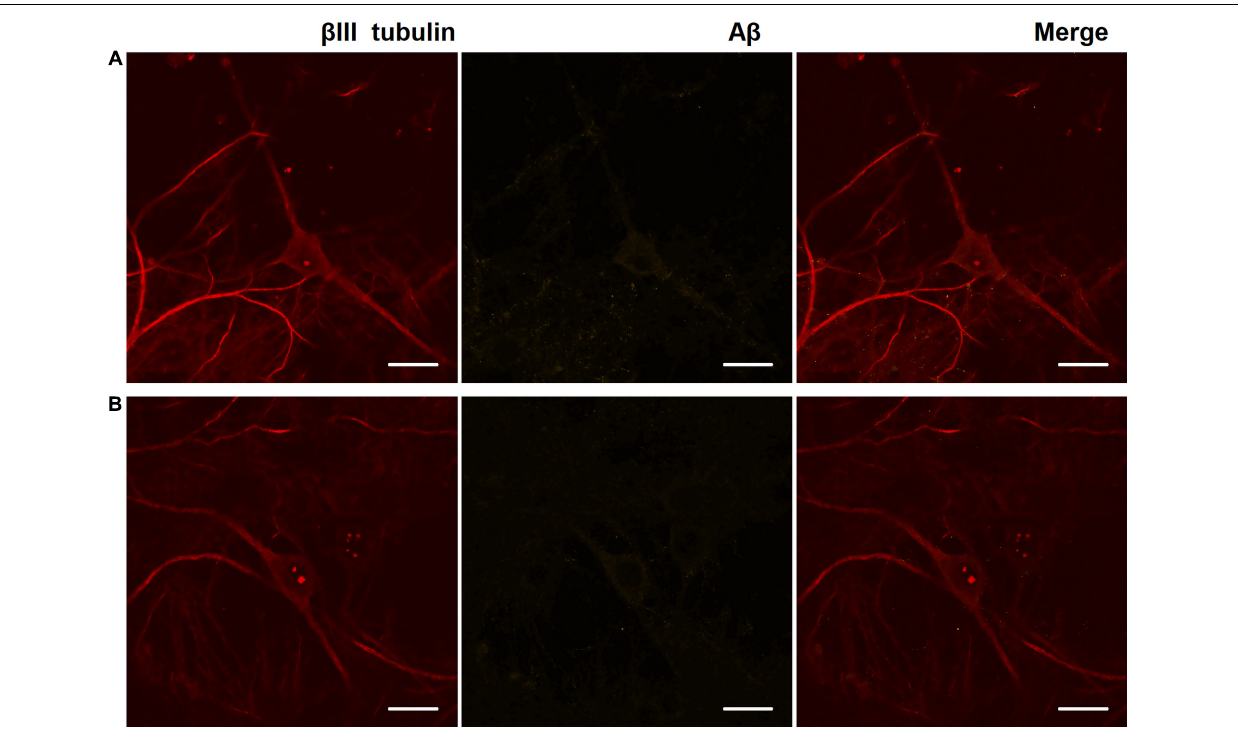
the chronic A β group had a significantly lower number of cells that exhibited Ca 2 + activity on DIV 21 and DIV 28 (DIV 21: sham, 80.06 ± 3.40%; chronic A β , 29.01 ± 16.38%; DIV 28: sham, 68.70 ± 9.53%; chronic